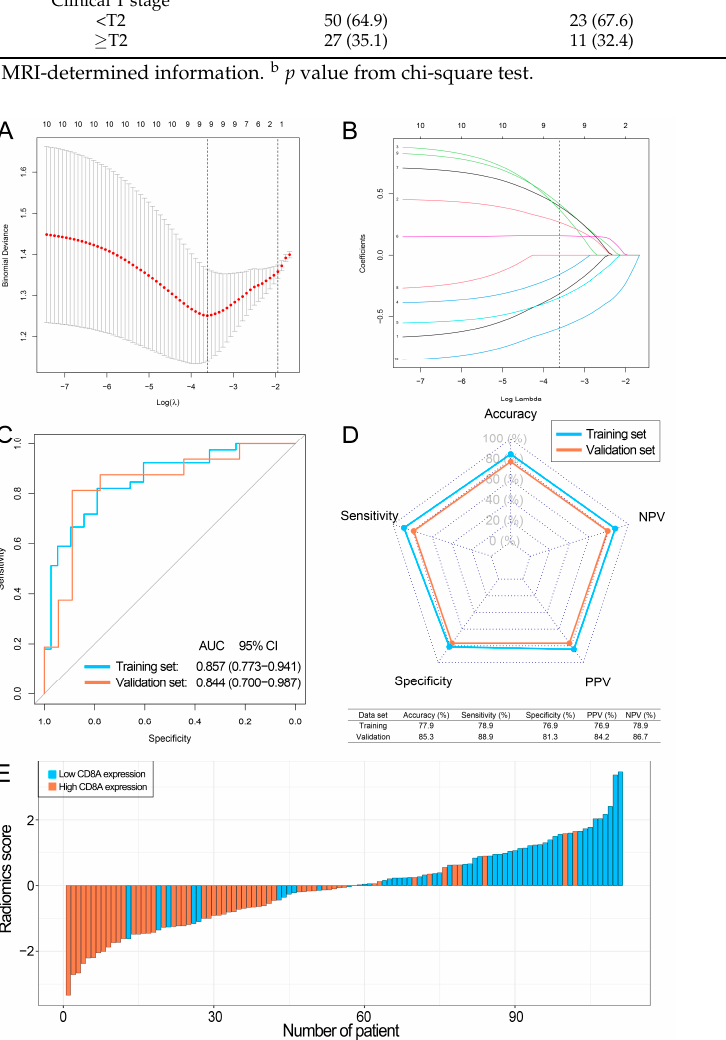
Figure 7. Construction and performance of the LASSO model (radiomics signature) in our center. ( A ) Optimal radiomics features selection based on the binominal deviance. ( B ) Distribution of LASSO coefficients for nine selected radiomics features. ( C ) AUCs of the LASSO model in the training and validation sets. ( D ) The comprehensive performance of the LASSO model in the training and validation sets. ( E ) Waterfall plot of the CD8A expression levels and radiomics scores in the combined training and validation sets. LASSO, least absolute shrinkage and selection operator; NPV, negative predictive value; PPV, positive predict value; AUCs, area under the ROC